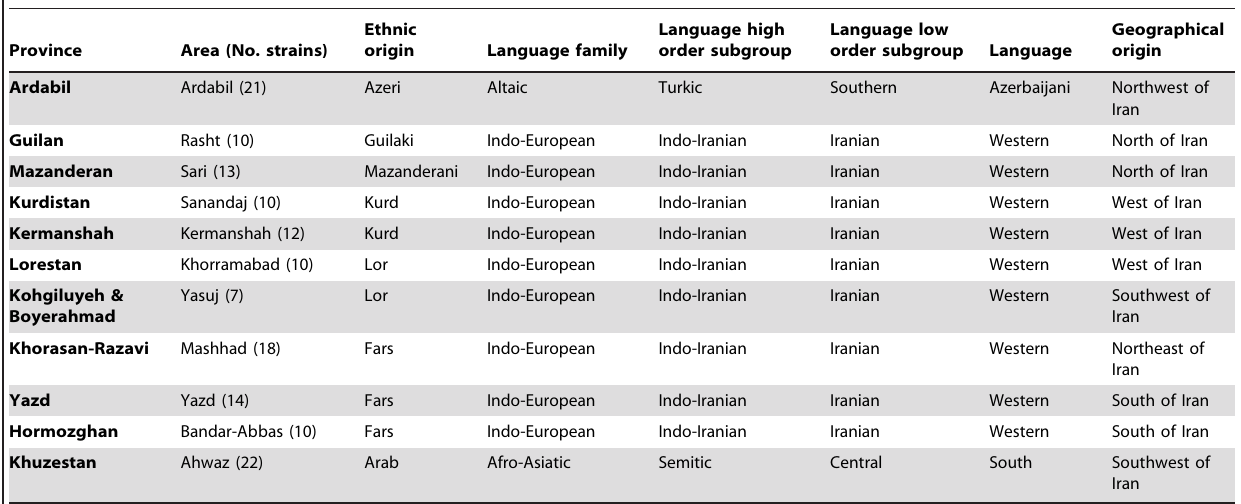
Table 1. Description of Iranian